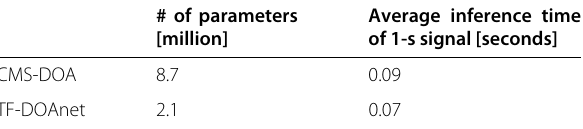
Table 6 Computational cost